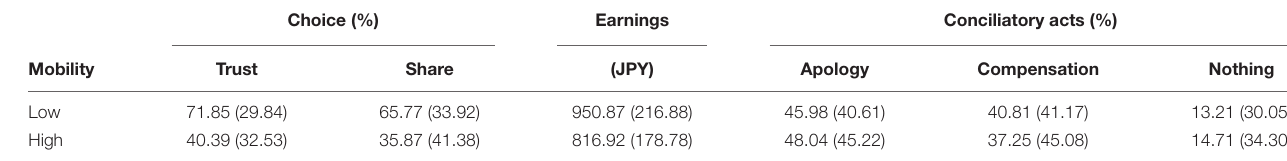
TABLE 3 | The means (SDs) of cooperation rate, the monetary earning, and the ratio of conciliatory acts by the mobility condition. Choice (%)